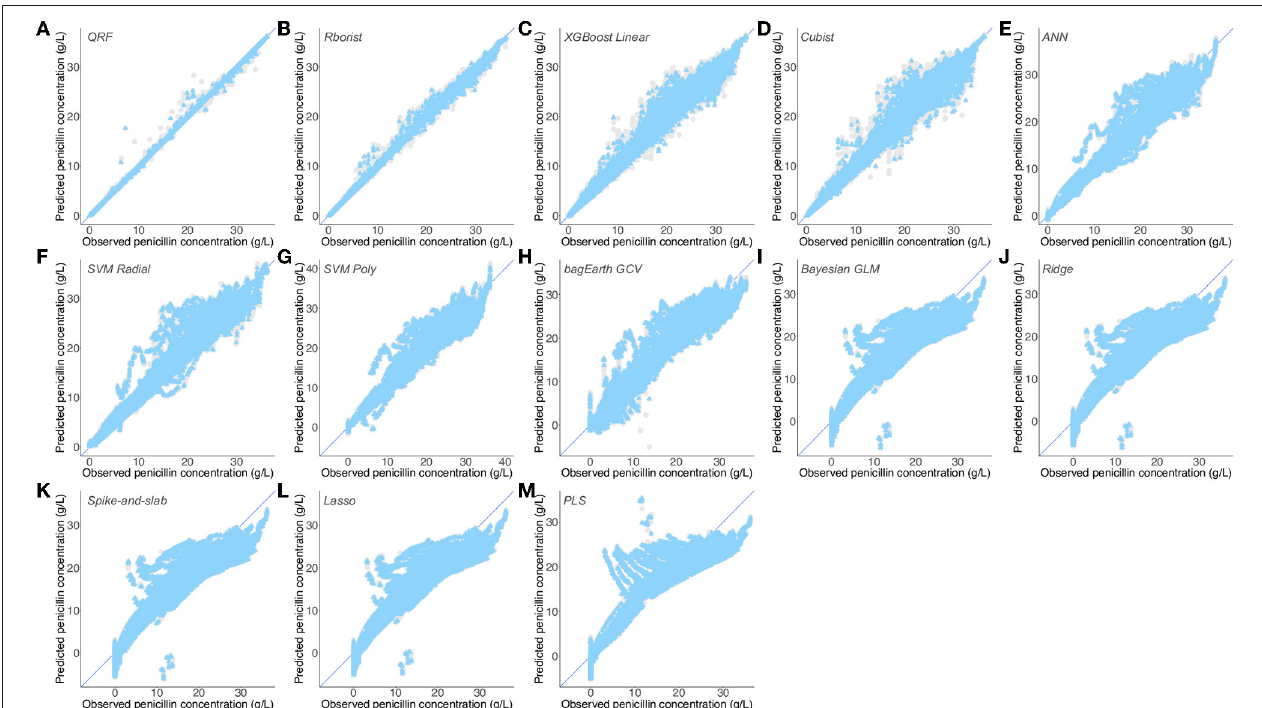
FIGURE 8 | Predictions of observed penicillin concentration by different predictive models. (A–M) Flux from the third dataset ( Supplementary Table 9 ) predicted by the QRF (A) , Rborist (B) , XGBoost Linear (C) , Cubist (D) , ANN (E) , SVM Radial (F) , SVM Poly (G) , bagEarth GCV (H) , Bayesian GLM (I) , Ridge (J) , Spike-and-slab (K) , Lasso (L) and PLS (M) models. Gray circles: training set, and blue triangles: test set. See Table 3 for the statistical measurements of each model.